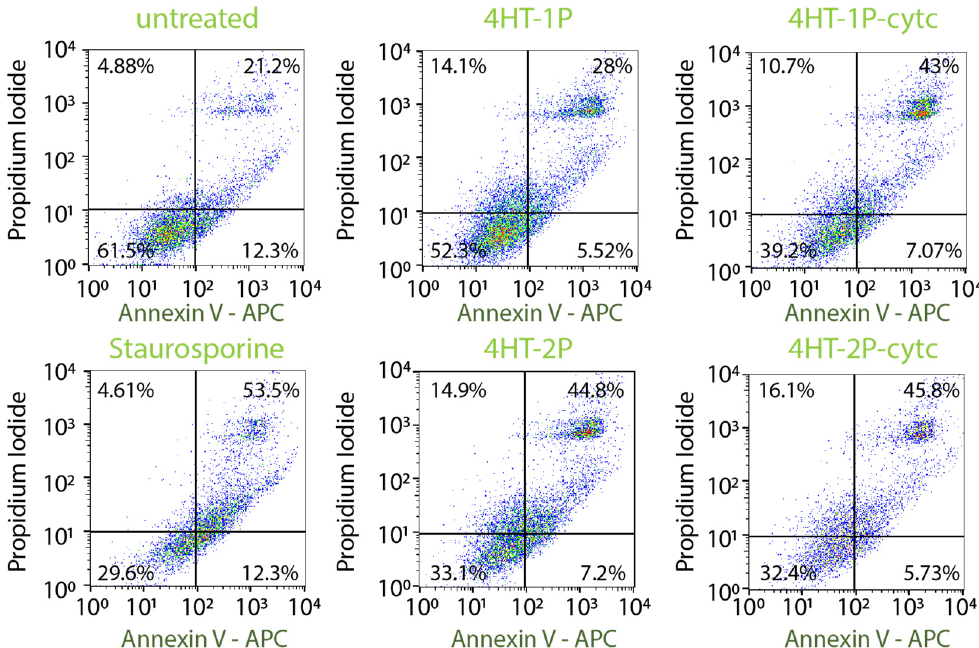
Figure A5. Palmitate-conjugated DNA nanotubes induce cell death in HeLa cells. Flow cytometry analysis of the Annexin V/Propidium Iodide-stained cells, 4 h after treatment with 1 µM palmitate-modified 4-helix DNA nanotubes (4HT). A palmitate-dependent increase of the apoptotic and necrotic fractions in the cell populations was observed.